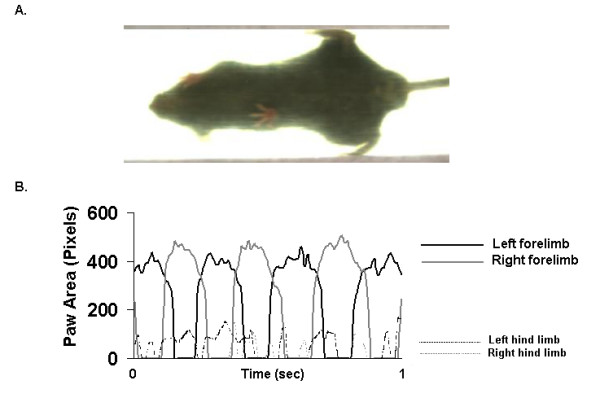
Ventral view of a 3NP-treated mouse attempting to walk. A. The ventral view of a 3NP-treated mouse attempting to walk on the treadmill belt moving at a speed of 34 cm/s but failing to engage the hind limbs in coordinated stepping. This animal braced its hind paws onto the base of the sidewalls of the walking compartment avoiding the moving treadmill belt. Only the forelimbs execute coordinated stepping sequences. B. Gait signals of the left and right forelimbs of a 3NP-treated mouse demonstrating coordinated stepping, despite hind limb failure of stepping. The signals of left and right hind limbs are not coordinated and reflect artefacts associated with the belt contacting the braced paws.